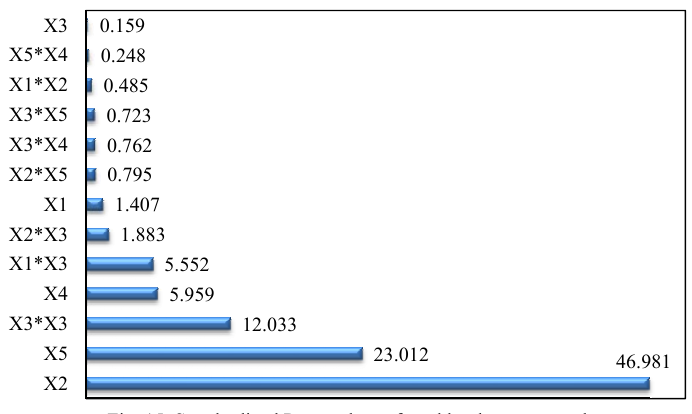
Fig. 15. Standardized Pareto chart of total hardness removal.